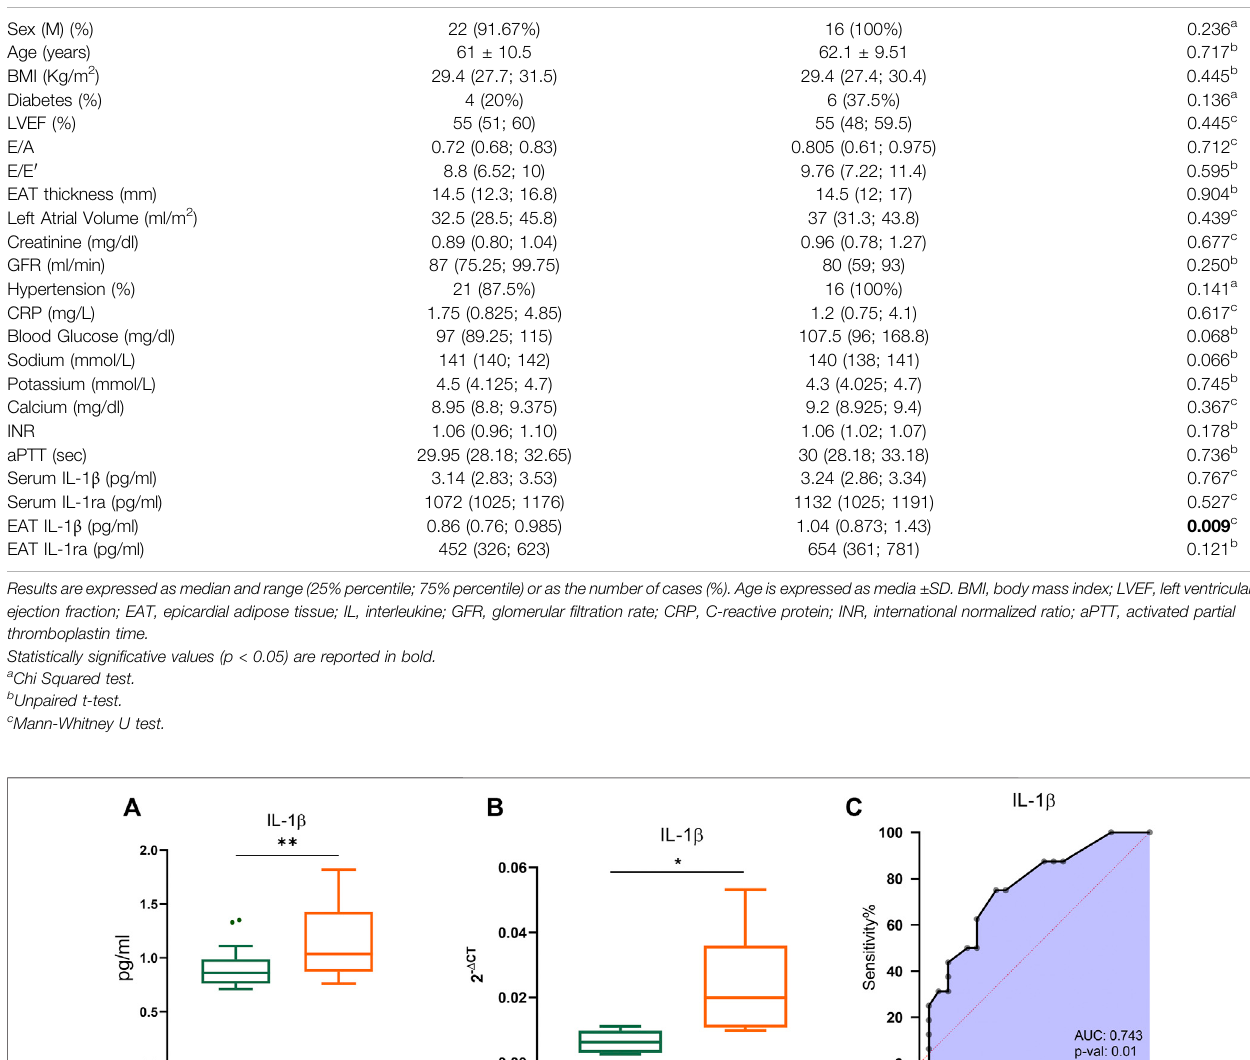
( Supplementary Figure S1 ). Overall atrial fi brosis was present in eight patients. Of note, no association was observed between POAF and the presence of atrial fi brosis ( p = 0.582, data not shown). Table 1 and Supplementary Table S1 ]. To gain insight into a possible involvement of local in fl ammation in POAF occurrence, we obtained conditioned media from EAT biopsies and analyzed a panel of in fl ammatory mediators.